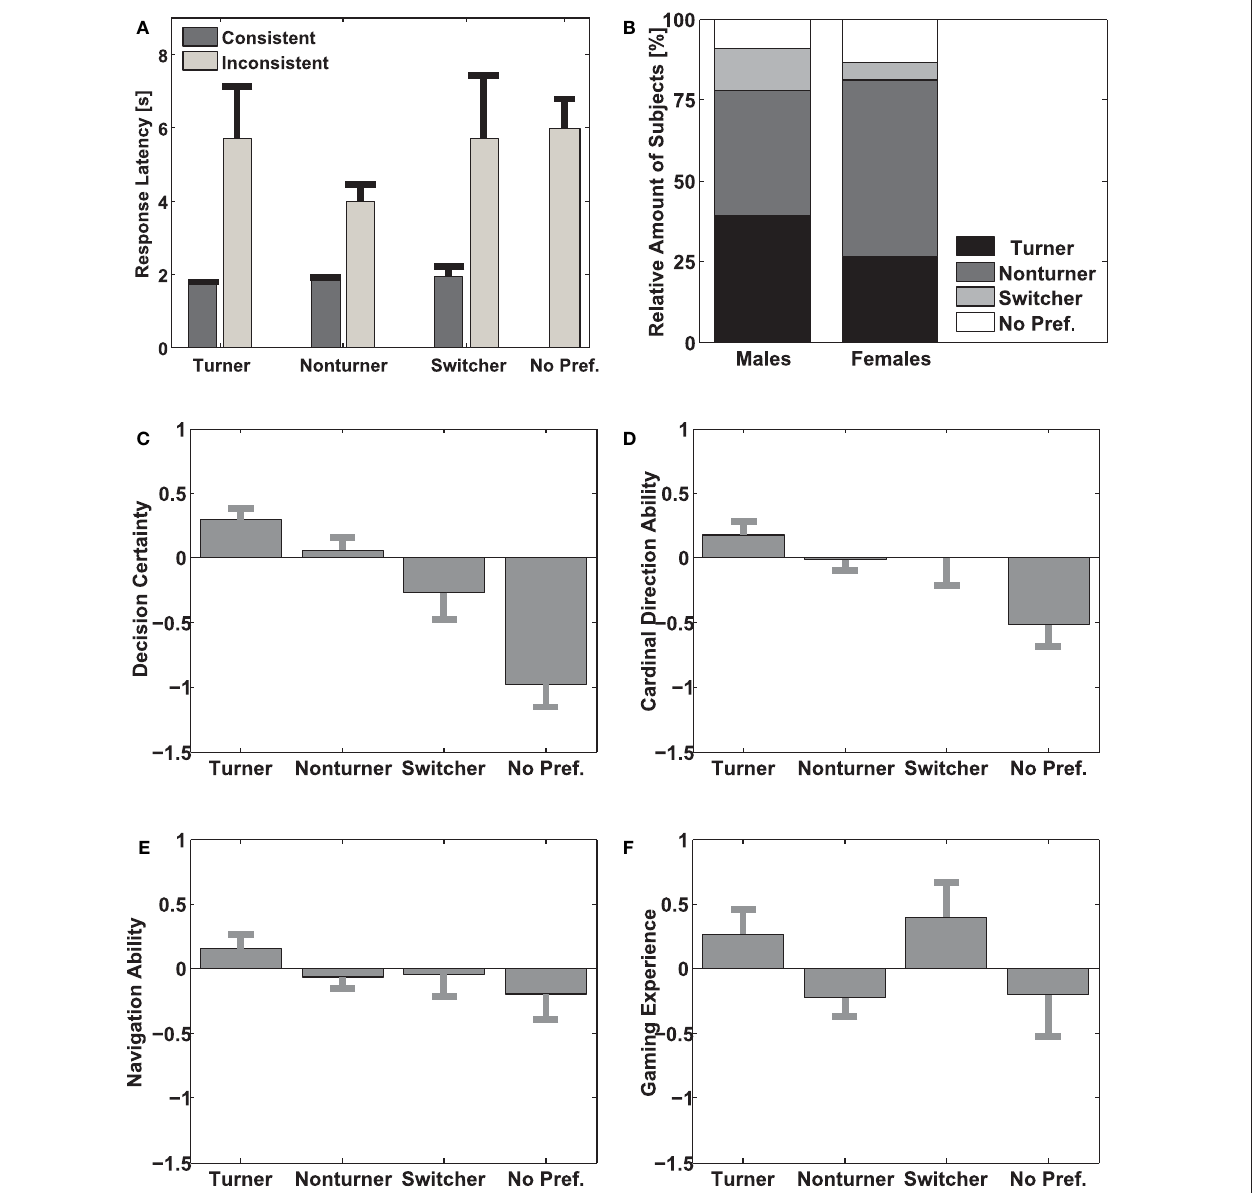
FIGURE 4 | Subgroup investigations (A) Response latency for strategy groups. The y-axis indicates the response time in seconds. The x-axis represents the four different strategy groups. The dark gray bars show the average response latency for responses inconsistent with the preferred strategy including standard errors; the light gray error bars show the average response latency for responses consistent with the preferred strategy; also including standard errors. (B) Distribution of strategy use for males and females. The y-axis indicates the relative amount of subjects belonging to a particular strategy group. The x-axis separates male and female participants.